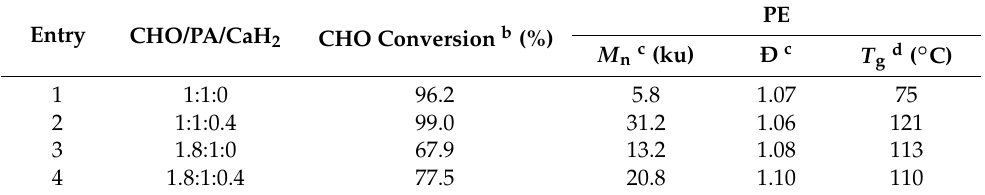
Table 2. Properties of PEs synthesized from CHO and PA in the presence of salen Cr and DMAP a